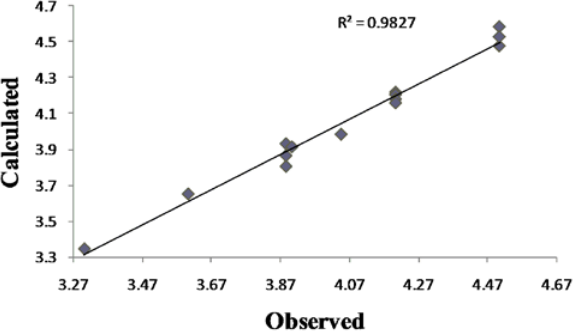
Figure 3. Plot of calculated vs. observed – log MIC values of the training set compounds obtained from Equation (3).